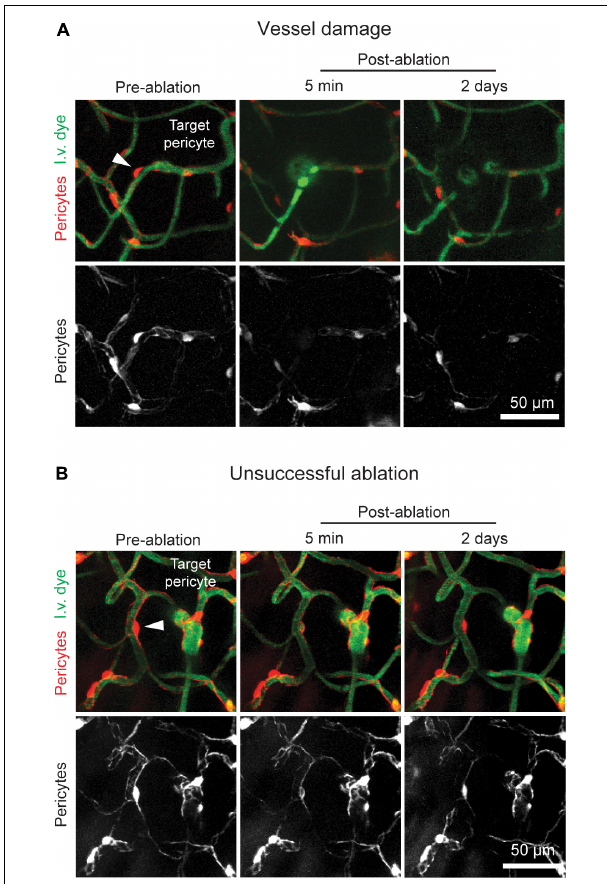
FIGURE 3 | Potential pitfalls of optical pericyte ablations. (A) An example of a damaged vessel following pericyte ablation. (B) An example of a failed pericyte ablation. The area is shown prior to pericyte ablation and 5 min and 2 days post-ablation. Pericytes are shown in red, and vessels are shown in green. The arrowhead indicates the targeted